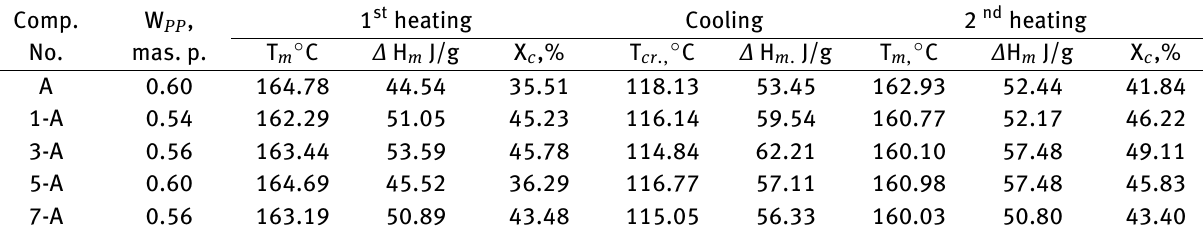
Table 6: Results of differential scanning calorimetry (DSC) measurements of the weathered (1032h) composites